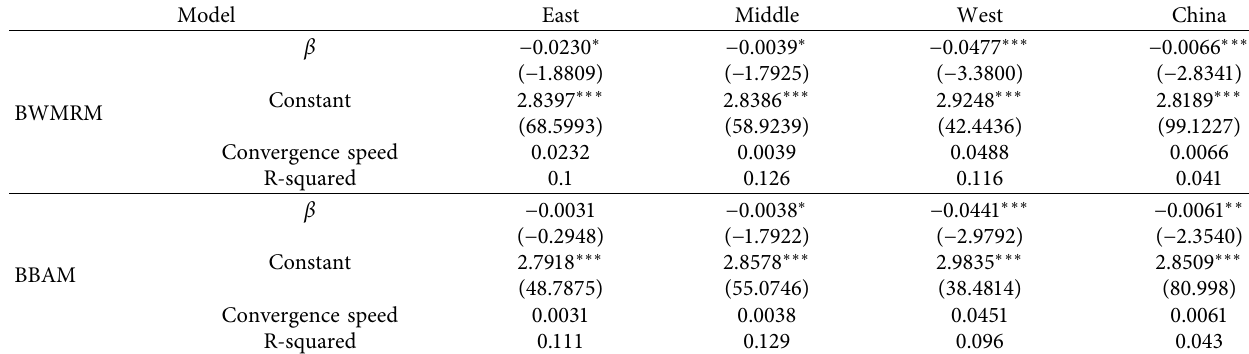
Table 6: The absolute β convergence test results of AGTFP in China and its subregions.